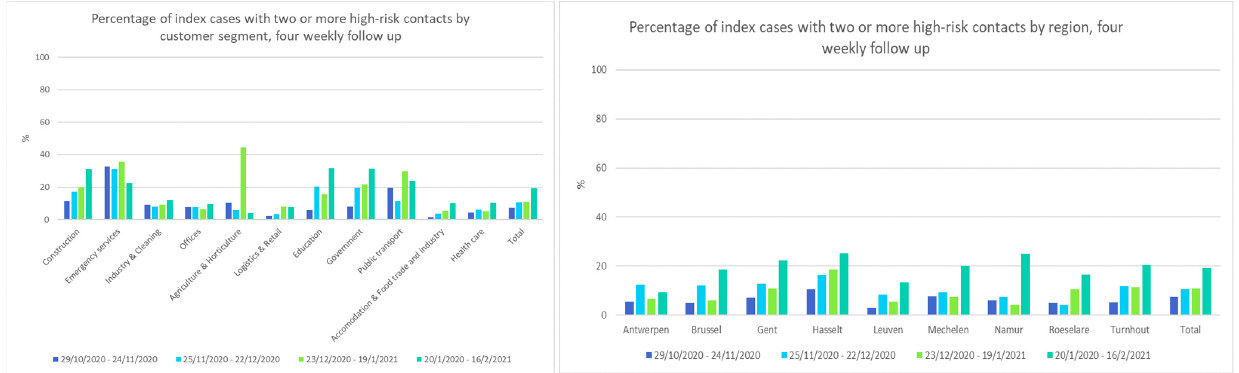
Figure 5. Four-weekly percentage of index cases with two or more high-risk contacts by segments under surveillance ( left ) and by geographical region ( right ).